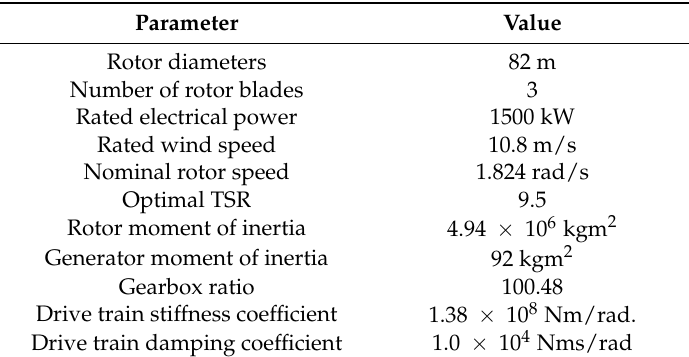
Table 1. Specifications of the concerned WT.